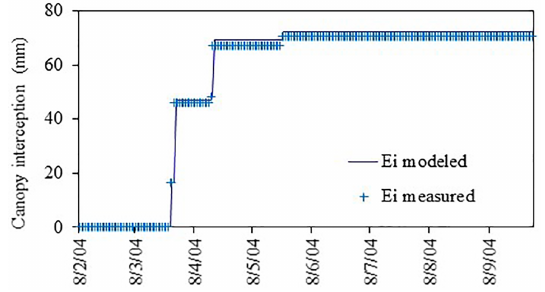
Figure 3. Cumulative measured versus modeled canopy intercep- tion data after van Dijk and Bruijnzeel